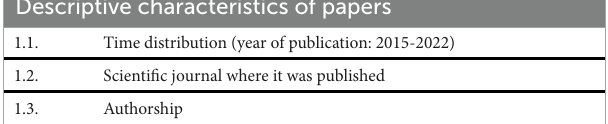
TABLE 5 Codes used to analyze the contents of articles.